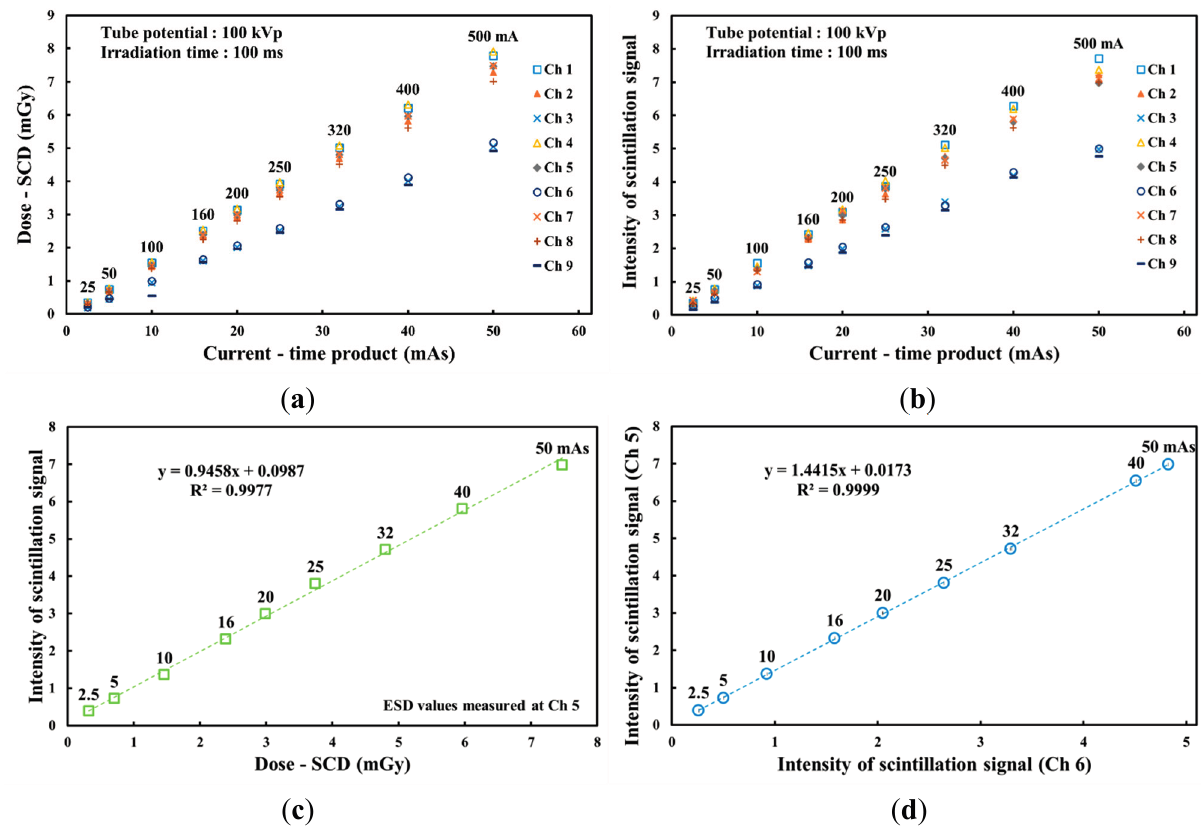
Figure 7. ( a ) Absorbed doses measured using the SCD and ( b ) light intensity measured using the phantom dosimeter from each probe. ( c ) Relationship between the light intensities of the phantom dosimeter and the ESDs of the SCD at Ch. 5 according to the current-time product. ( d ) Correlation between two probes of the phantom dosimeter at each measuring point according to the current-time